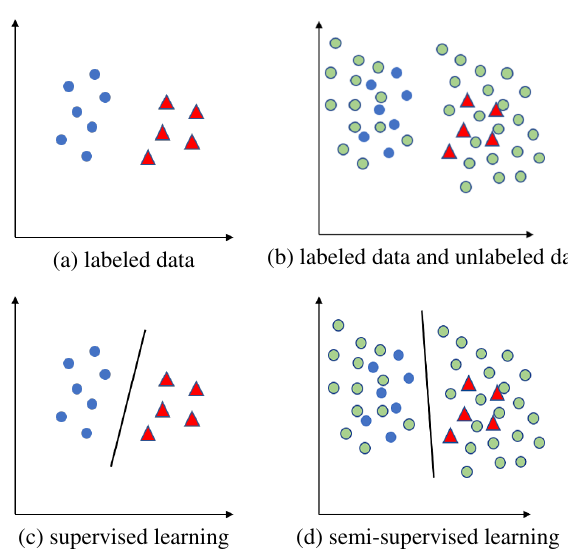
Figure 1. Example of supervised learning and semi-supervised learning. The blue and red dots denote labeled samples and the green dots denote unlabeled